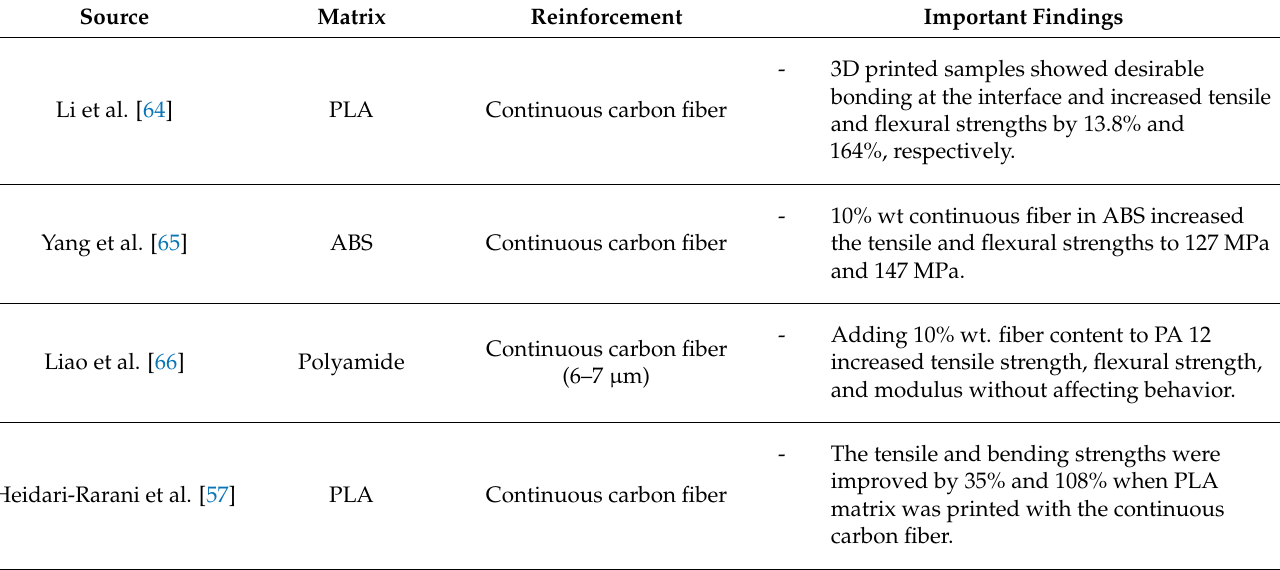
Table 4. Table displaying the matrix, type of fiber reinforcement, and type of printing